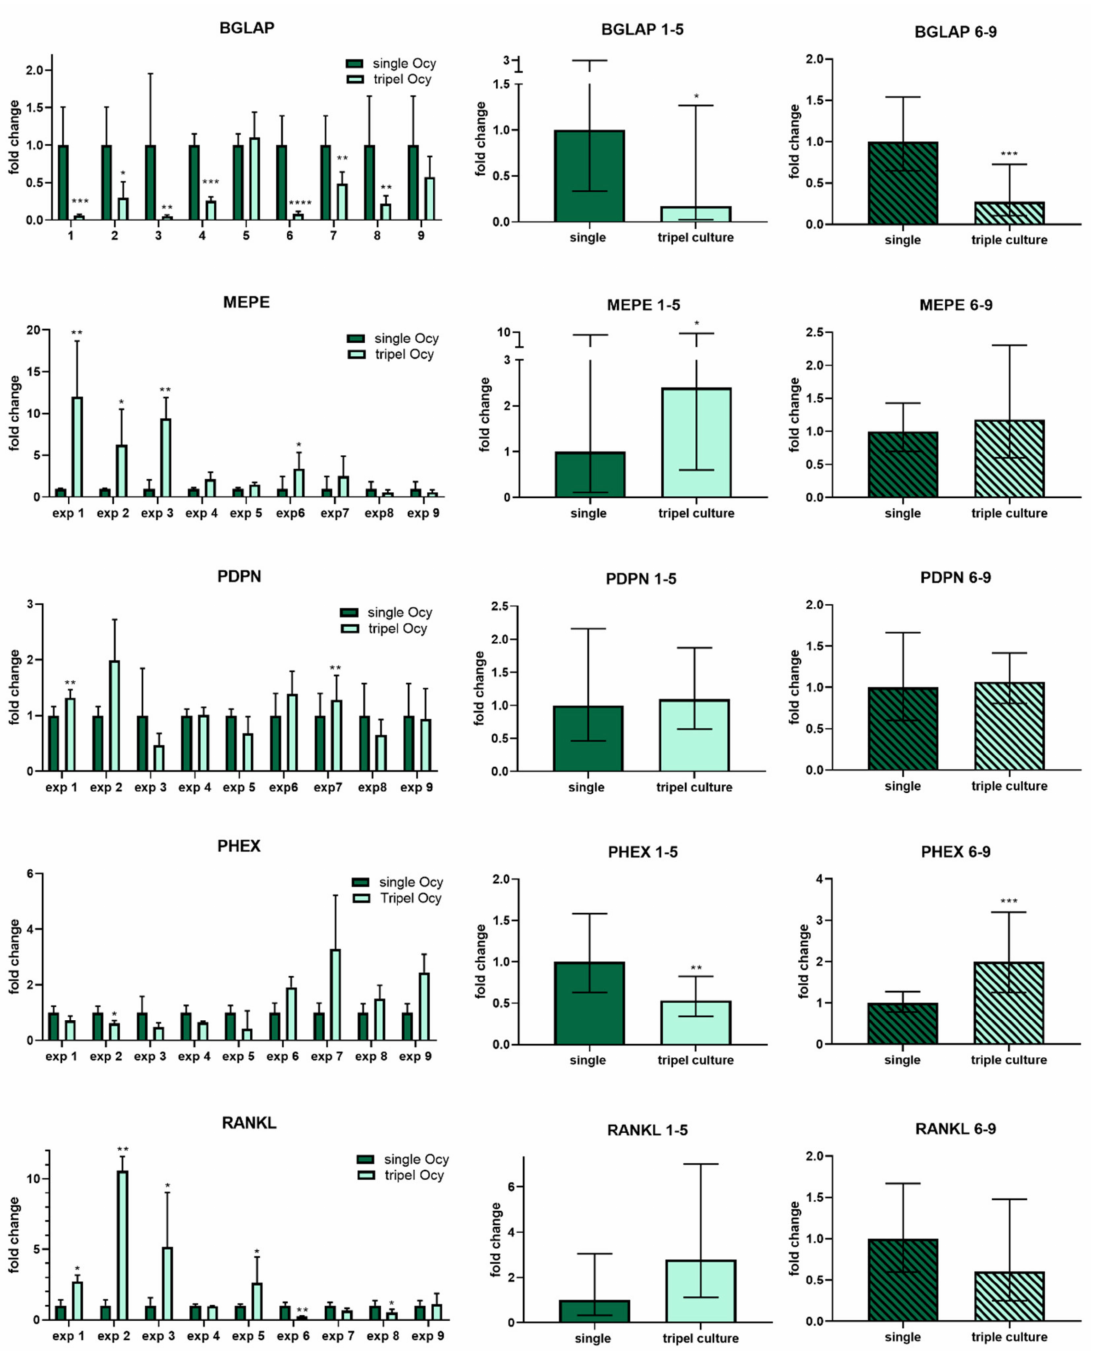
Figure 3. Gene expression analysis of osteocyte marker genes BGLAP, E11, RANKL, PHEX and MEPE for osteocytes cultivated in single culture compared to triple culture with osteoclasts and osteoblasts. Left column shows data of 9 different experiments. Middle column: Summarized data for experiments 1–5. Osteocytes were co-cultivated with spatially separated osteoblasts and osteoclasts (patterned seeding). Right column: Summarized data for experiments 6–9 (mixed seeding of OB and OC). Gene expression was normalized to the expression of GAPDH and fold changes were calculated using the CT method. Fold changes +/ − upper and lower limits. * p < 0.05; ** p < 0.01, *** p < 0.001, **** p <